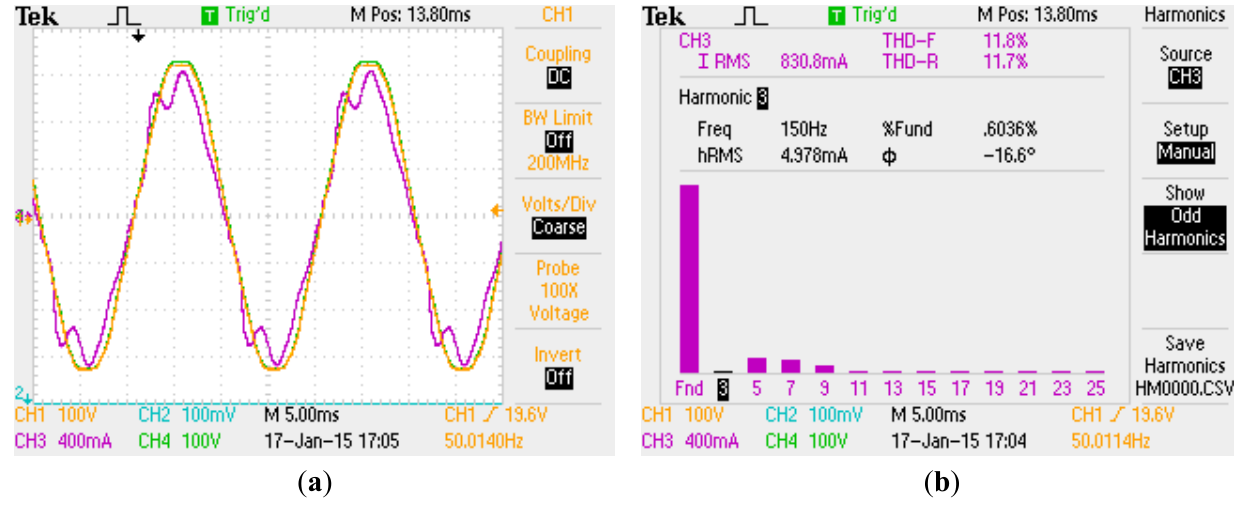
Figure 9. ( a ) Grid’s voltage and current waveforms after compensation of 3rd harmonic; ( b ) Grid’s current harmonic spectrum after compensation of 3rdharmonic. 3rd harmonic is